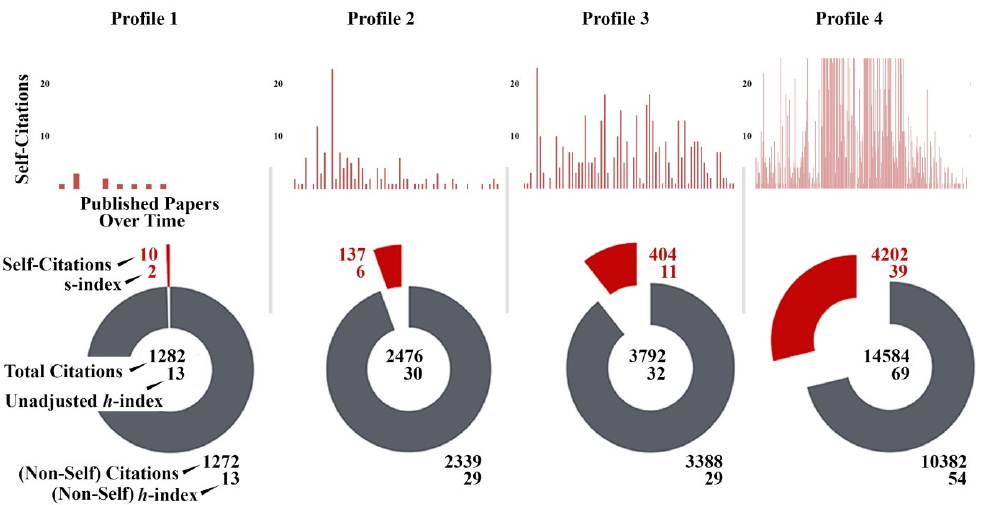
Figure 1. Transparency in citation reporting. Self ‐ citation data (red) is shown for four biomedical researchers based on their papers in PubMed. The top row is a manuscript level view of how each individual cites themselves over time. Each red bar represents a single paper that has been self ‐ cited to some degree. Note that the cutoff for clarity here is just beyond 20 citations. It was chosen to provide a sense of how each researcher distributes self ‐ citations over his or her published papers. The bottom row reveals the proportion of total citations that are self ‐ cites.